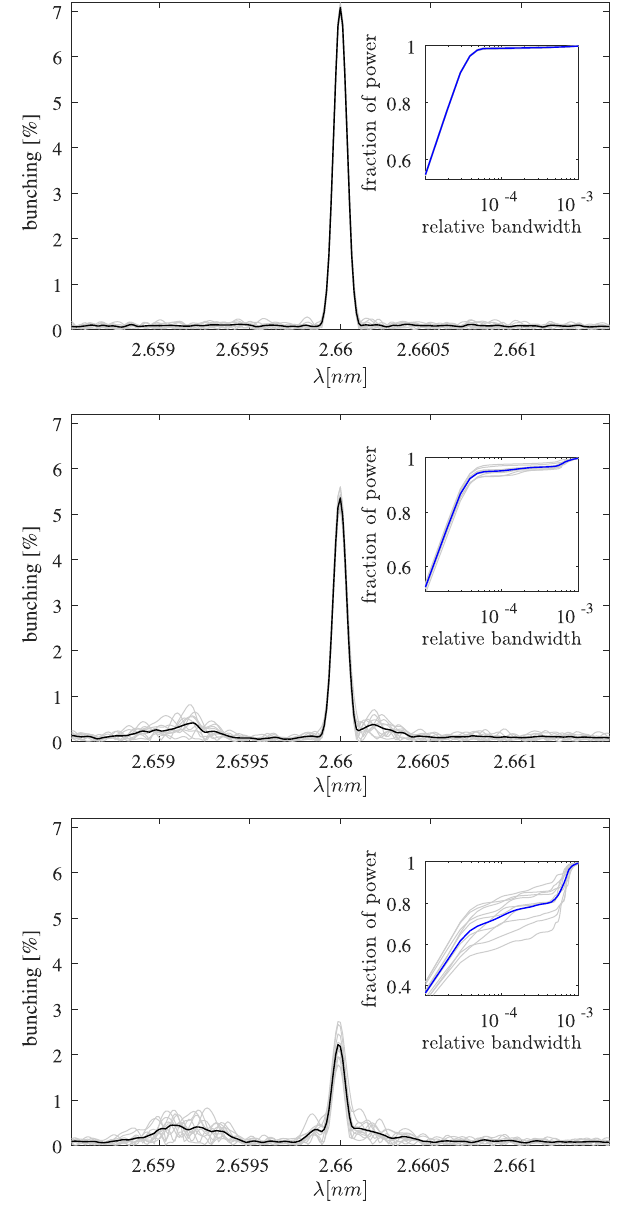
FIG. 9. EEHG bunching simulations for the a E ¼ 100 har- monic of 266 nm lasers in the presence of broadband MBI energy ffiffiffi p ¼ 1 , (b) σ ¼ 3 , modulations with rms energy spread (a) σ p p 0 0 ¼ 3 . The beam is modeled after the parameters of LCLS- (c) σ p 0 II; E ¼ 4 GeV, σ E ¼ 500 keV, and σ z =c ¼ 100 fs ( σ 0 ¼ 10 − 5 ). The EEHG energy modulations are A 1 ; 2 ¼ 3 and the dis- ð 1 Þ ¼ 12 mm ( B ¼ 35 . 46 ) and R ð 2 Þ ¼ 118 μ m persions are R 1 56 56 ( B 2 ¼ 0 . 35 ). At these settings ξ E ¼ − 0 . 53